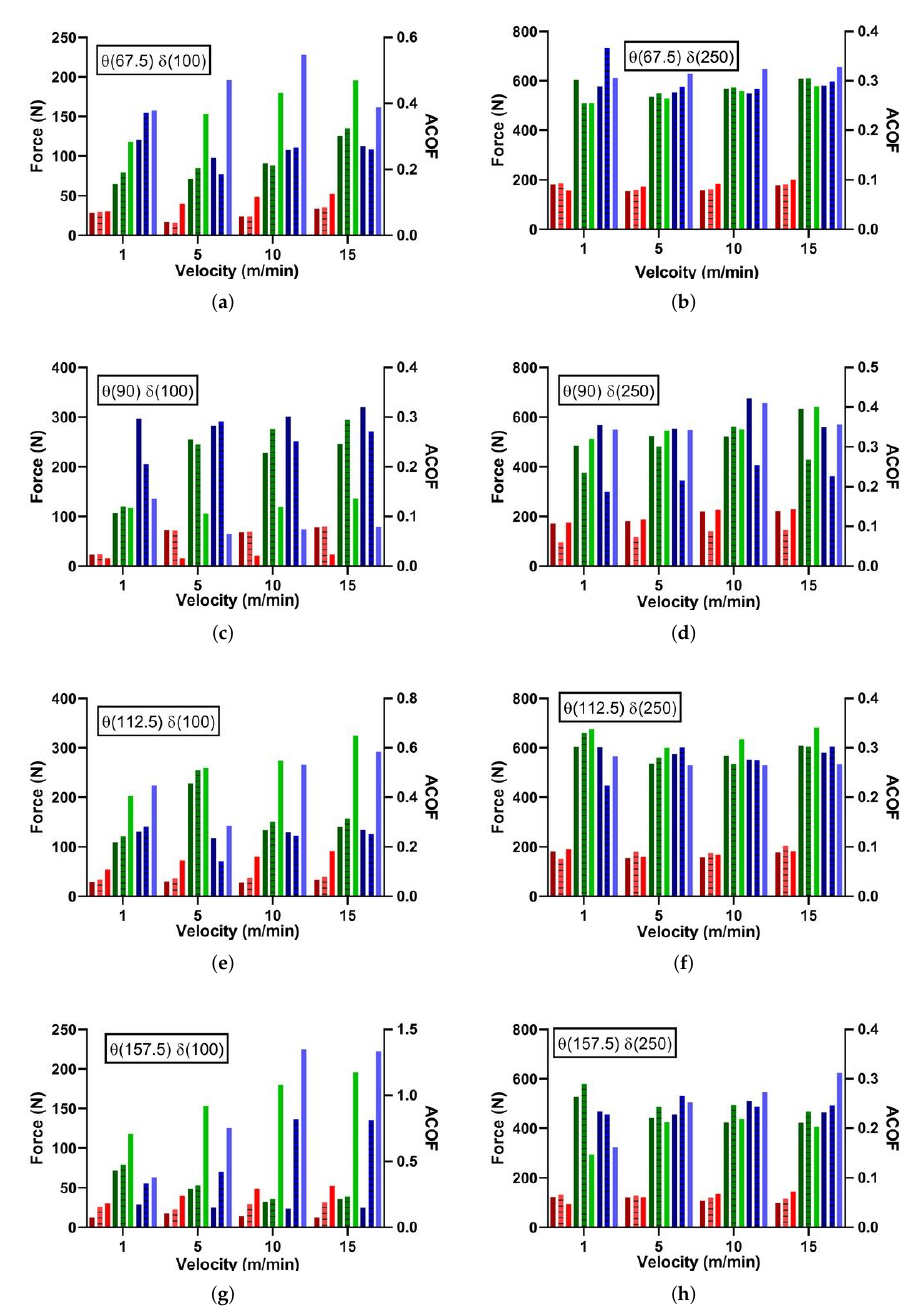
Figure 12. Experimental Results: FE Comparison of Dynamic Friction Model vs. Constant Friction Coefficient for Open-Loop